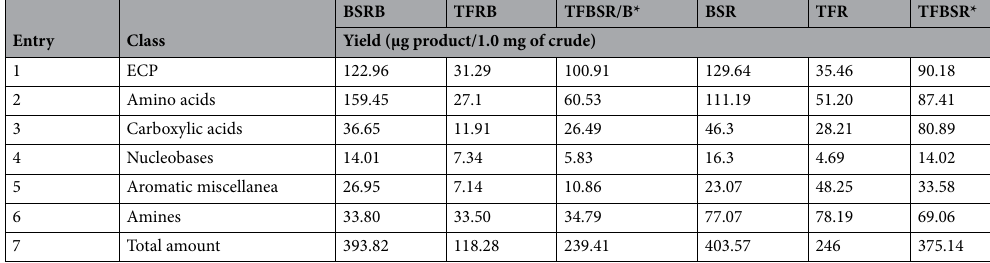
Table 1. Total yield of products grouped for chemical class: ECP elemental prebiotic chemical precursors compounds, amino acids, carboxylic acids, nucleobases, aromatic miscellanea, amines. BSRB borosilicate in buffer, TFRB Teflon in buffer, TFBSR/B Teflon in buffer in the presence of pieces of borosilicate, BSR borosilicate without buffer, TFR Teflon without buffer, TFBSR Teflon without buffer in the presence of pieces of borosilicate, ECP elemental prebiotic chemical precursors.